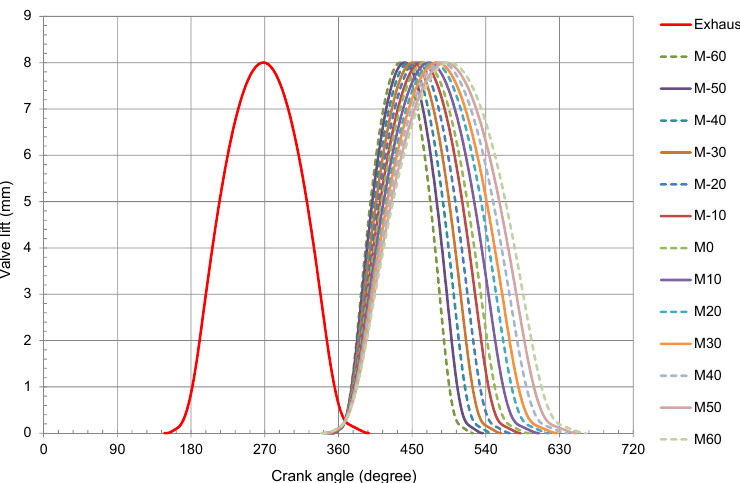
Figure 2. Engine model.